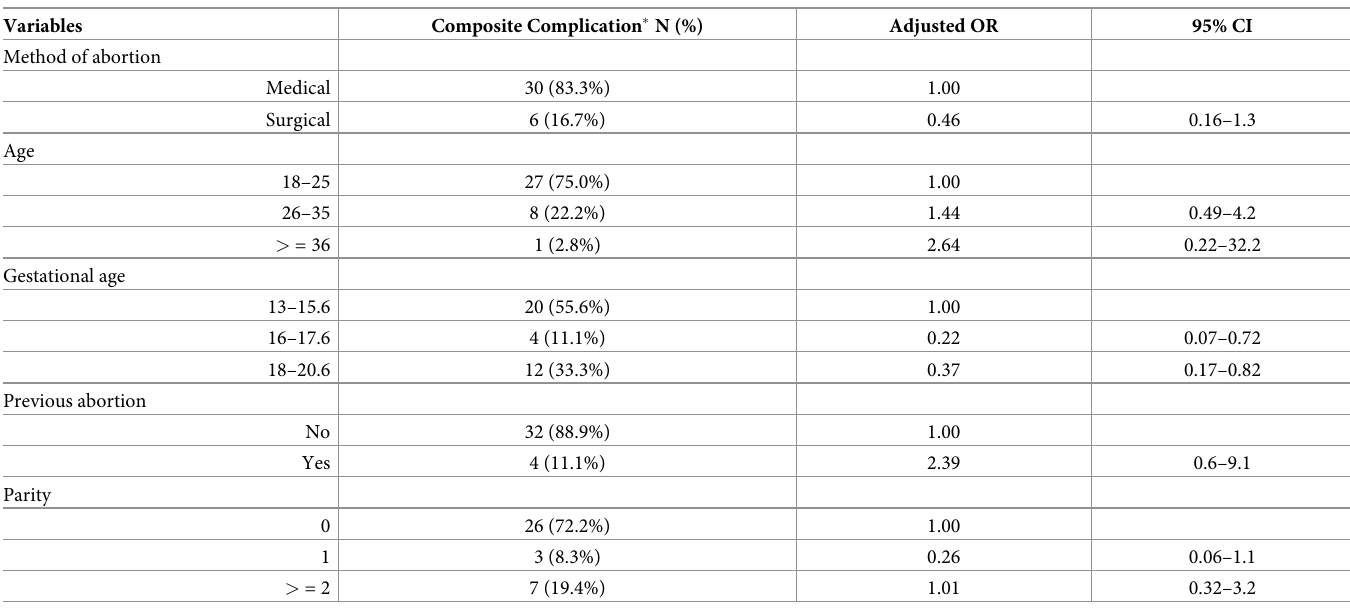
Table 4. Multiple logistic regression analysis of composite